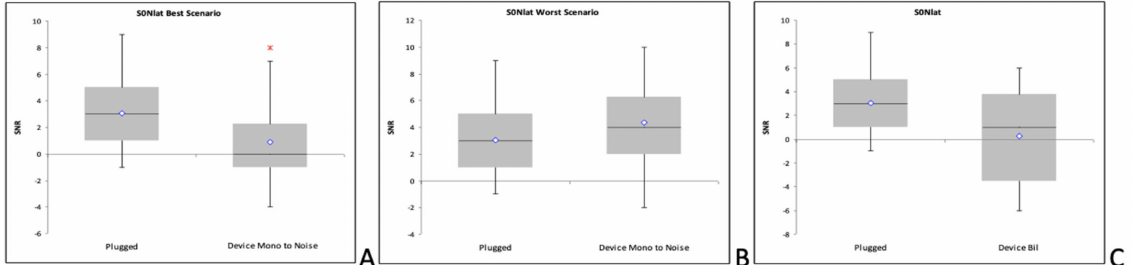
Figure 5. Aided squelch SRT50. ( A ) Overall scores with noise lateralized to the unaided ear, or “best scenario”; ( B ) Overall scores with noise lateralized to the aided ear, or “worst scenario”; ( C ) Overall bilaterally aided